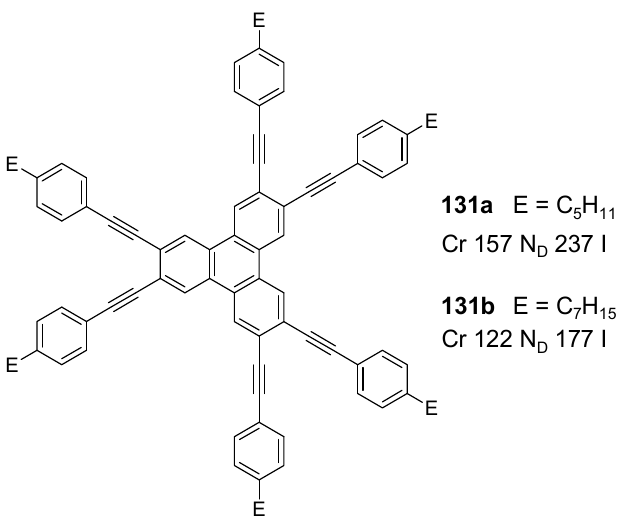
Figure 32. Praefkes multiyne